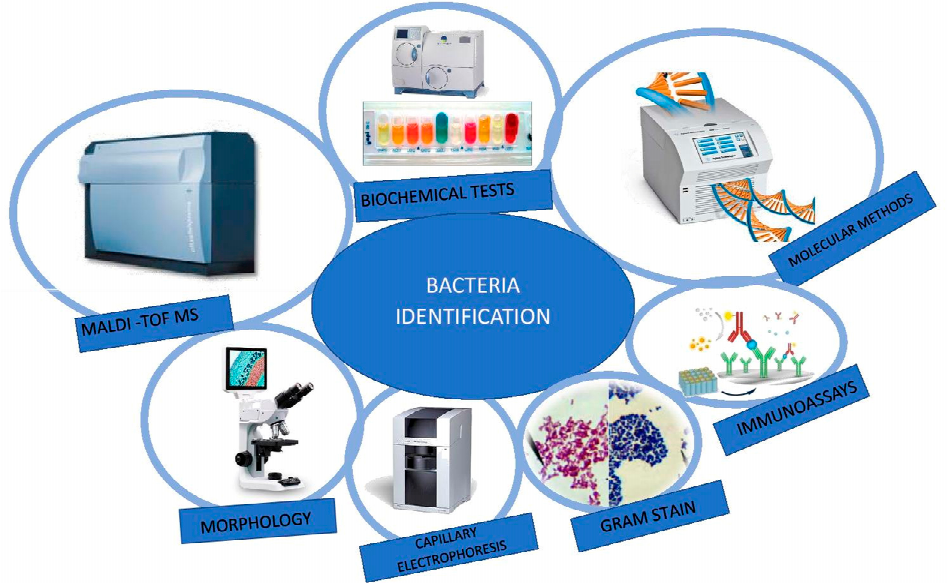
Figure 6. The popular methods to microorganism identification.